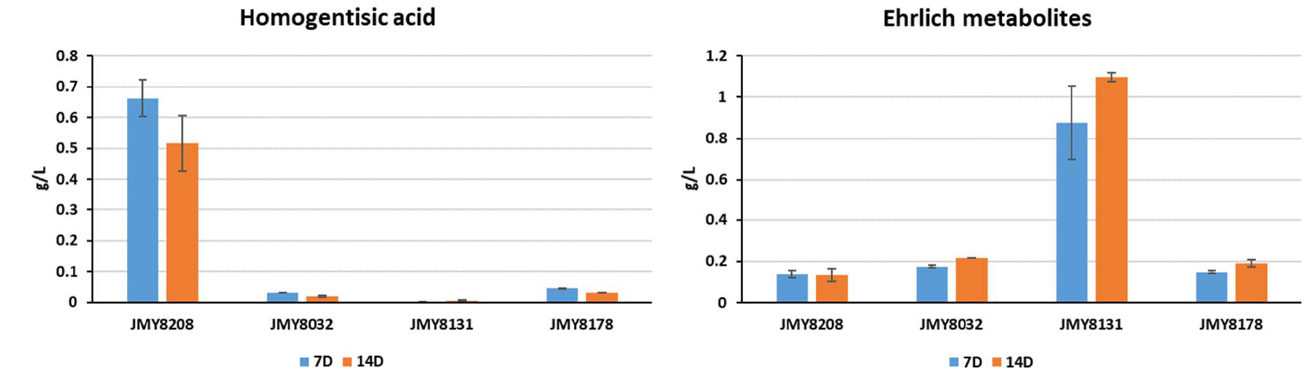
Figure 5. Production of homogentisic acid and Ehrlich metabolites (in g/L) by the four study strains (JMY8032, JMY8131, JMY8178, and JMY8208) in YNB medium. The individual quantities of 2-4OHPE, 4OHPAA, 2PE, and PAA were summed to obtain the total quantity of Ehrlich metabolites. 7D: 7 days of culture; 14D: 14 days of culture.